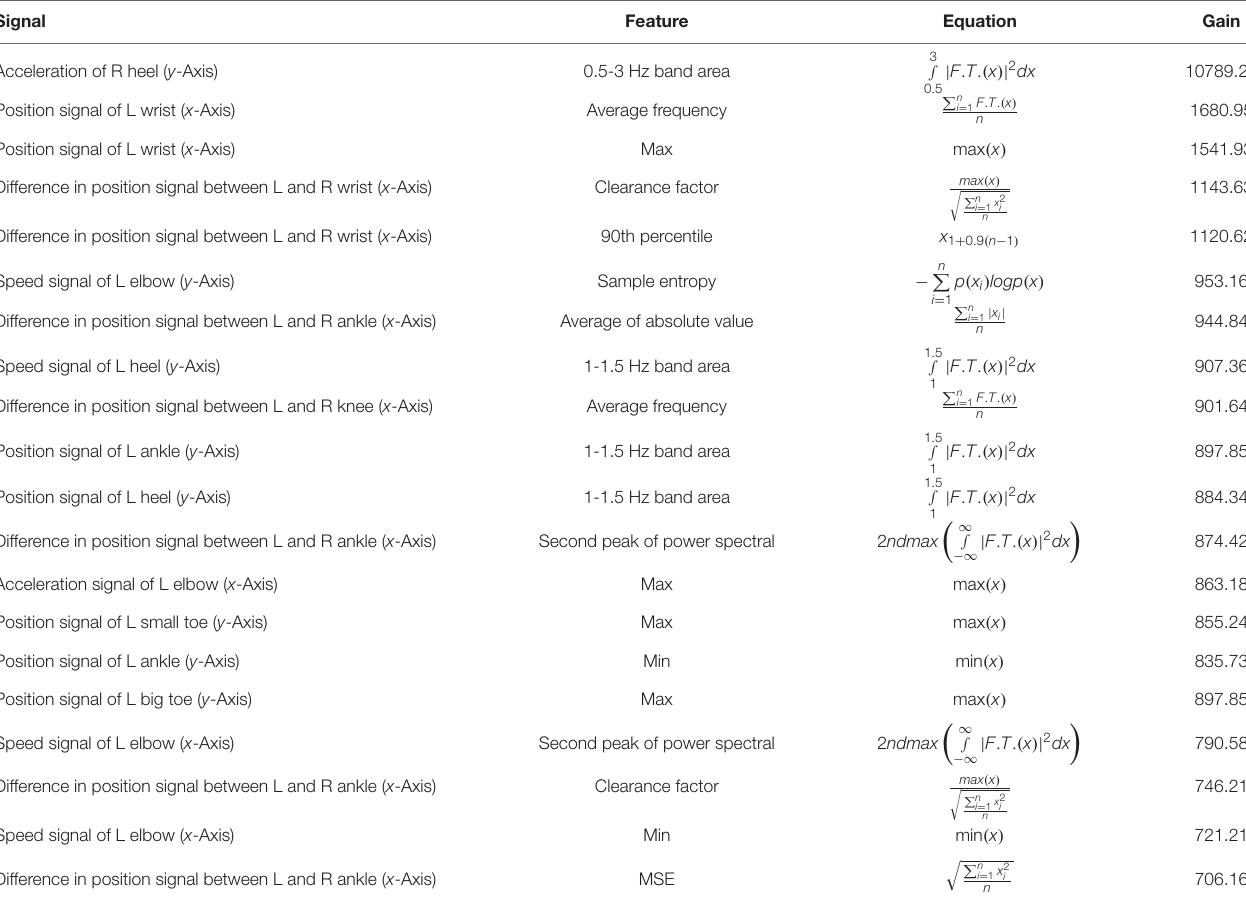
TABLE 4 | Feature importance for the Walk-FOG recognition model based on the XGBoost gain (top 20).